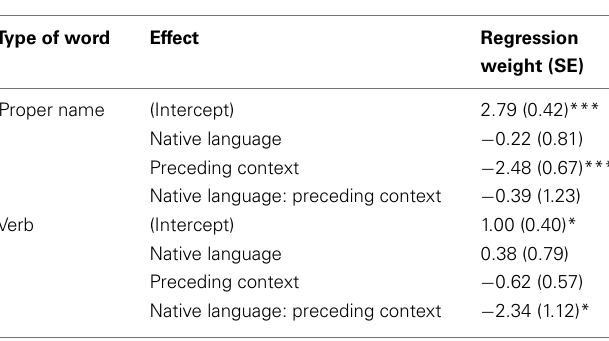
Table 1 | Experiment 1: Regression weights for the models for nouns and